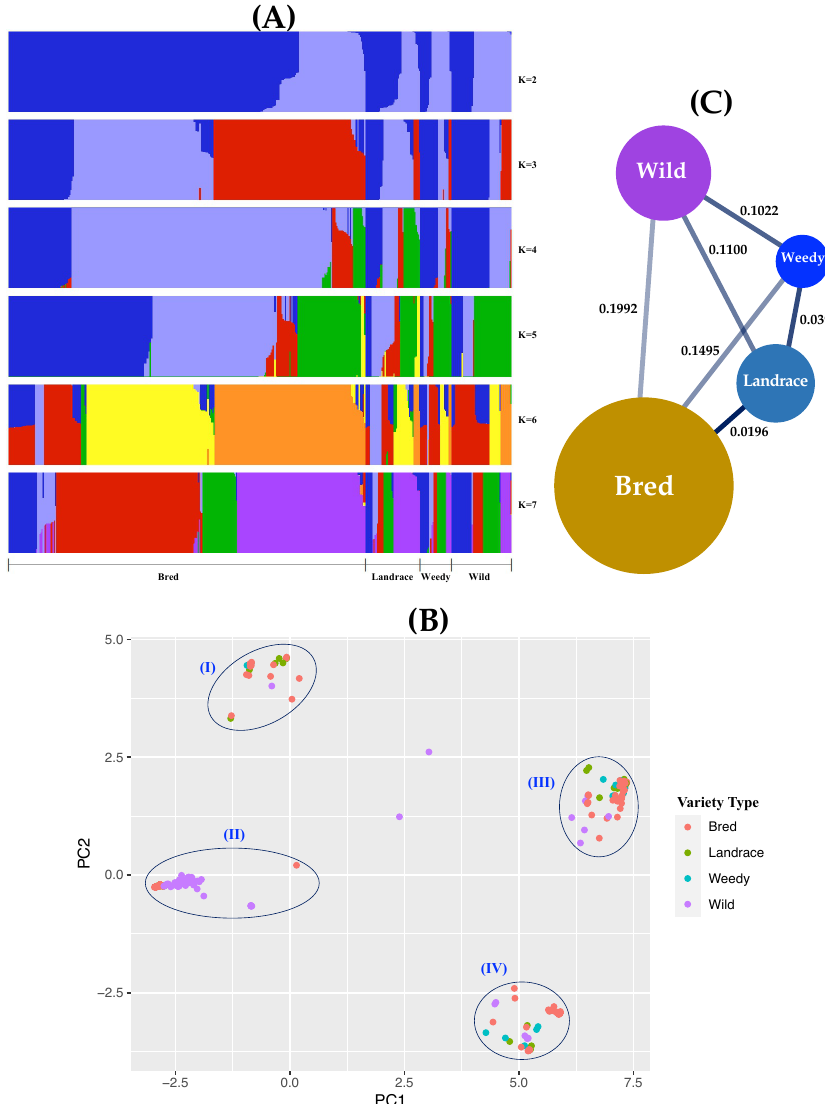
Figure 2. Estimate of structure and population differentiation within the gene region of GBSSII ( Os07g0412100 ) in the Korean rice collection in terms of different varietal types (landrace, weedy, bred, and wild). ( A ) Population structure of the GBSSII gene in the 475 Korean rice accessions clustered by increasing K value from 2 to 7. The different colors of each K value refer to the different numbers of clustered populations. ( B ) Two-dimensional (2D) principal component analysis (PCA) of the 475 Korean rice accessions. ( C ) Pairwise estimates of genetic differentiation ( F ST values) of the GBSSII gene among different varietal types of the 475 Korean rice